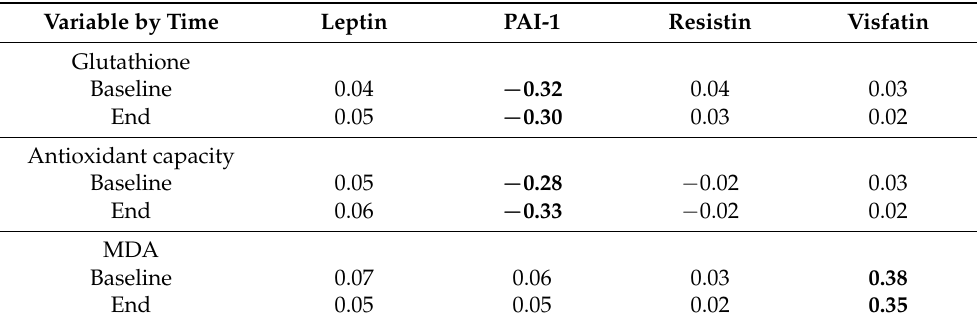
Table 3. Partial correlation coefficients among maternal serum antioxidant, lipid oxidation and adipokine biomarkers adjusted for maternal age, BMI, and prenatal vitamin use at baseline and end of study.